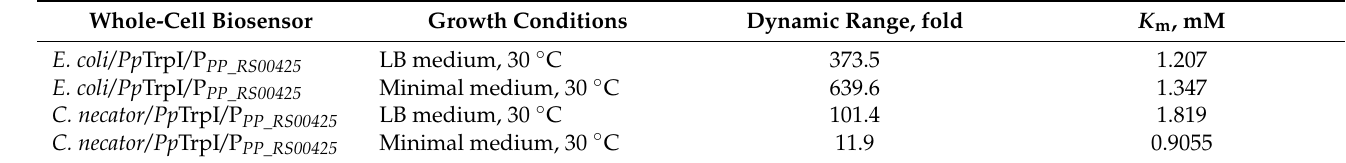
Table 1. Parameters of biosensors based on the indole-inducible system Pp TrpI/P PP_RS00425 .